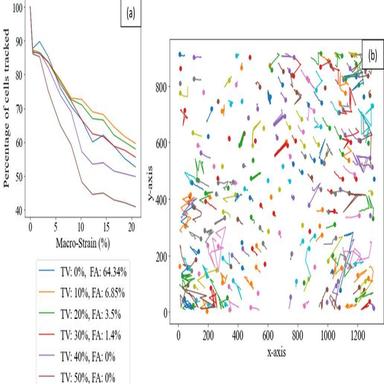
Results showing the sensitivity of tracking to T-value (TV), (a) percentage of cells tracked with respect to the number of detected cells in the first frame under varying T-values ( the percentage of false assignments (FA) for each T-value is shown in the legend), (b) trajectories of tracked cells for a T-value of 0% (i.e. no T-value is used).